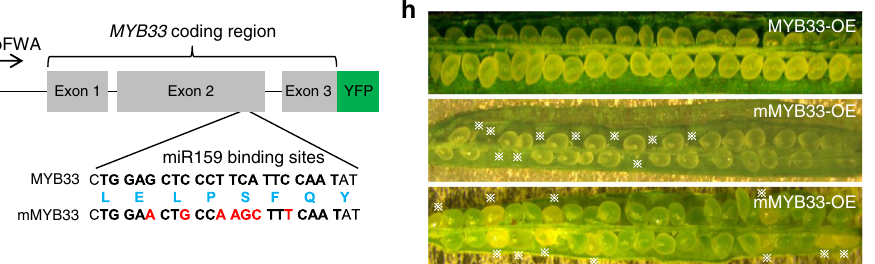
mutant (Fig. 2g and Supplementary Fig. 2e), further indicating that the defective endosperm development in the mir159abc triple mutant is due to defective paternal miR159 activity. However, as three MIR159 genes were obviously detected in the central cell before fertilization (Supplementary Fig. 4a-c) and loss-of- maternal miR159 caused seed abortion (Fig. 1), the investiga- tion on the role of maternal miR159 will provide additional information on the biological signi fi cance of parentally trans- mitted miRNA in early seed development. As our fi nding that paternal miR159-dependent repression of maternal MYB33 and MYB65 after fertilization is necessary to initiate endosperm nuclear division, the mechanism by which maternal MYB33 and MYB65 inhibit the central cell division triggered by fertilization remains unknown. A previous study showed that MYB33 and MYB65 negatively regulate cell pro- liferation in vegetative tissue 46 , indicating the potential role of MYB33 and MYB65 as a molecular switch in dividing cells. In addition, loss of activity in the PcG proteins caused uncontrolled endosperm nuclear divisions independent of fertilization 47 . A